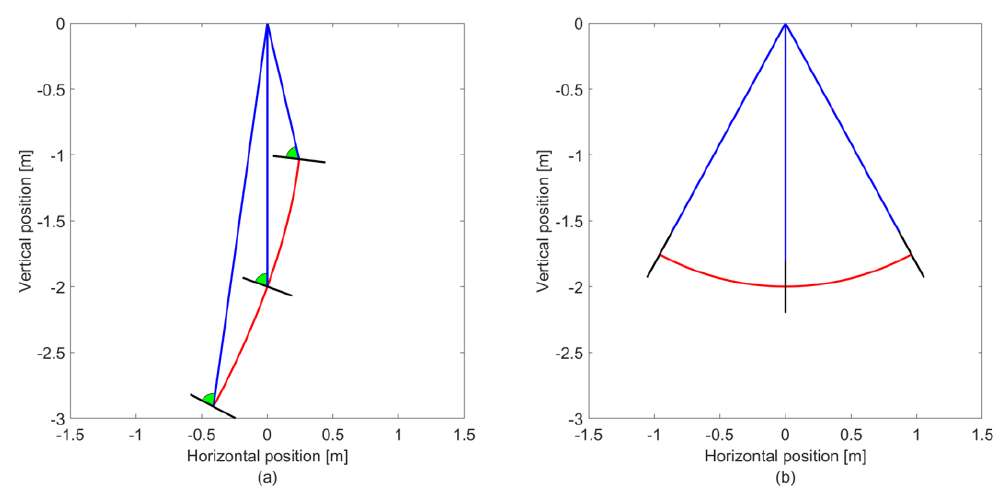
Figure 3. Hide orientation for an angle of incidence of ( a ) 70 ◦ and ( b ) 0 ◦ . The blue lines represent the trajectories of the electron beam at different deflection angles in the x-y plane, the red curves represent the surface of the hide, the black lines are the normals to the hide and the green regions in ( a ) is to show that the angle between the beam and the normal to the hide is constant regardless of beam deflection